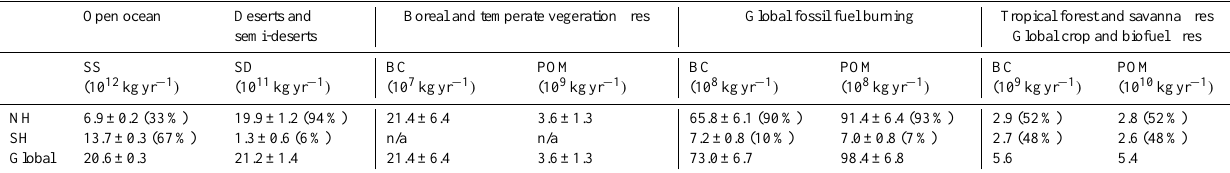
Table 2. Annual aerosol emissions by source types in the Northern and Southern Hemispheres, and globally over the 10 yr (SS = sea salt, SD = soil dust, BC = black carbon, POM = particulate organic